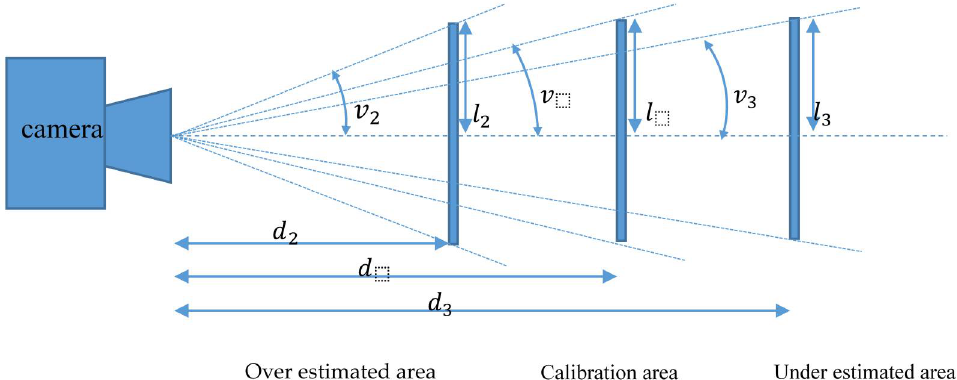
Figure 4. An illustration of how a calibration area with length, (cid:1864) , is perceived by a camera at different distances, (cid:1856),(cid:1856) (cid:2870) and (cid:1856) (cid:2871) . If an object is moved closer to the camera it will be detected as larger than it really is, (cid:1864) (cid:2870) , and if an object is moved further away from the camera it will be detected as smaller than it really is, (cid:1864) (cid:2871)